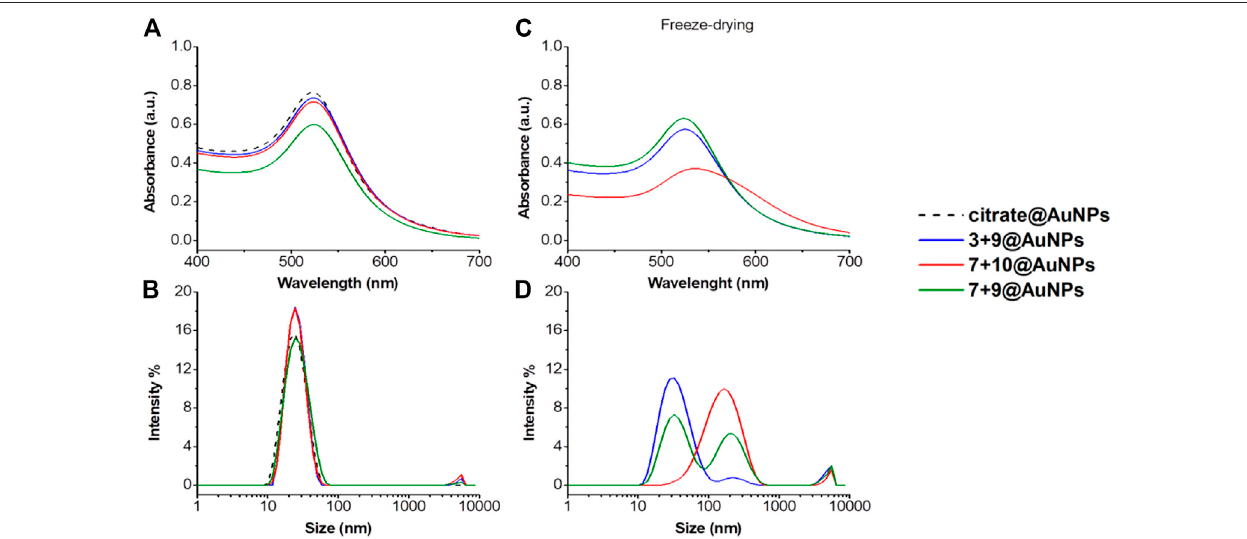
FIGURE4|(A) Absorptionspectraand (B) sizedistributionbyintensityofcitrate@AuNPs(dash)andfunctionalized-AuNPswithpeptides 3 + 9 (blue), 7 + 10 (red), 7 + 9 (green) ratio 80:20. Mean DLS results are given for three different measurements. The hydrodynamic diameter is found 22.7 ± 0.2 nm PdI 0.2 ± 0.02 for citrate@ AuNPs, 23.7 ± 0.6 nm PdI 0.2 ± 0.05 for 3 + 9 @AuNPs, 24.3 ± 0.6 nm PdI 0.2 ± 0.02 for 7 + 10 @AuNPs, and 23.4 ± 0.1 nm PdI 0.2 ± 0.02 for 7 + 9 @AuNPs. (C) Absorption spectra and (D) size distribution by intensity of functionalized-AuNPs after freeze-drying. Mean DLS results are given for three different